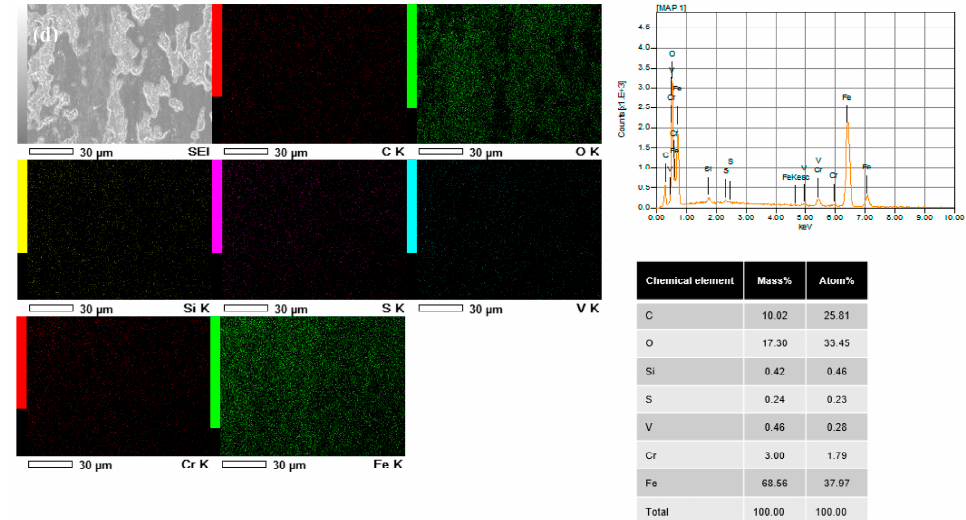
Figure 10. Energy-dispersive X-ray spectroscopy (EDX) spectra of the wear track of the bulk ( a , b ) and 3D-printed ( c , d ) AISI H13 tool steel specimens before and after UNSM treatment.